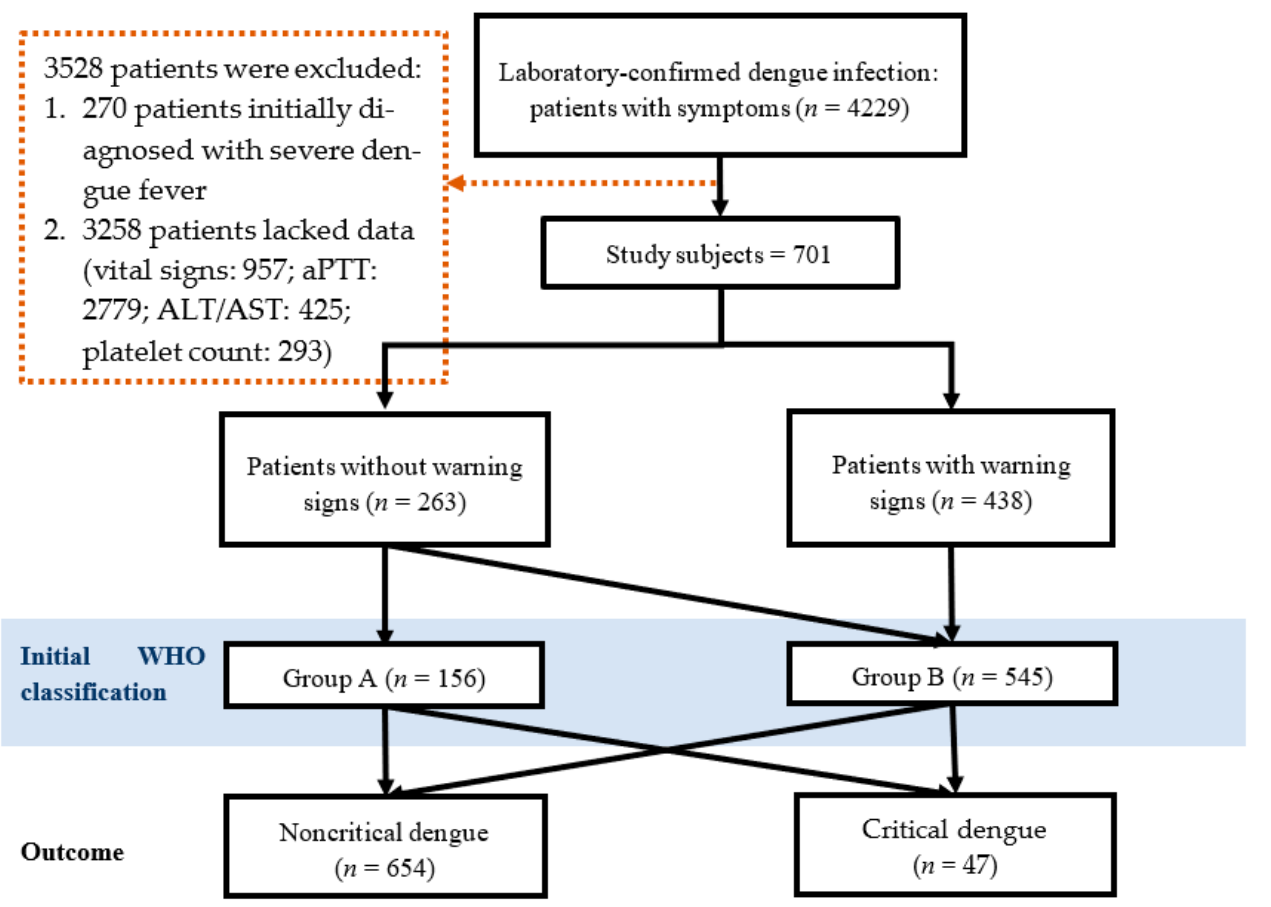
Figure 1. Flow chart of the patients who met the inclusion/exclusion criteria for the study popula- tion.